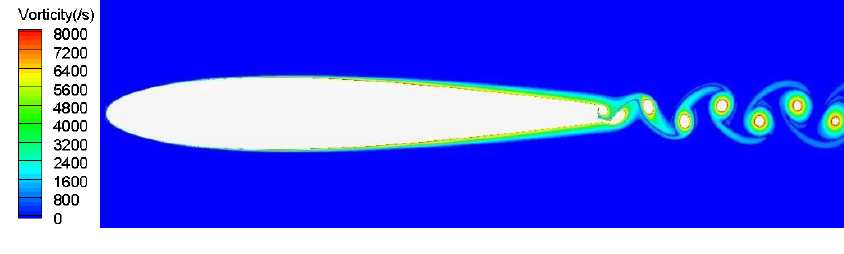
Figure 24. Vortex shedding of the 0012 model.